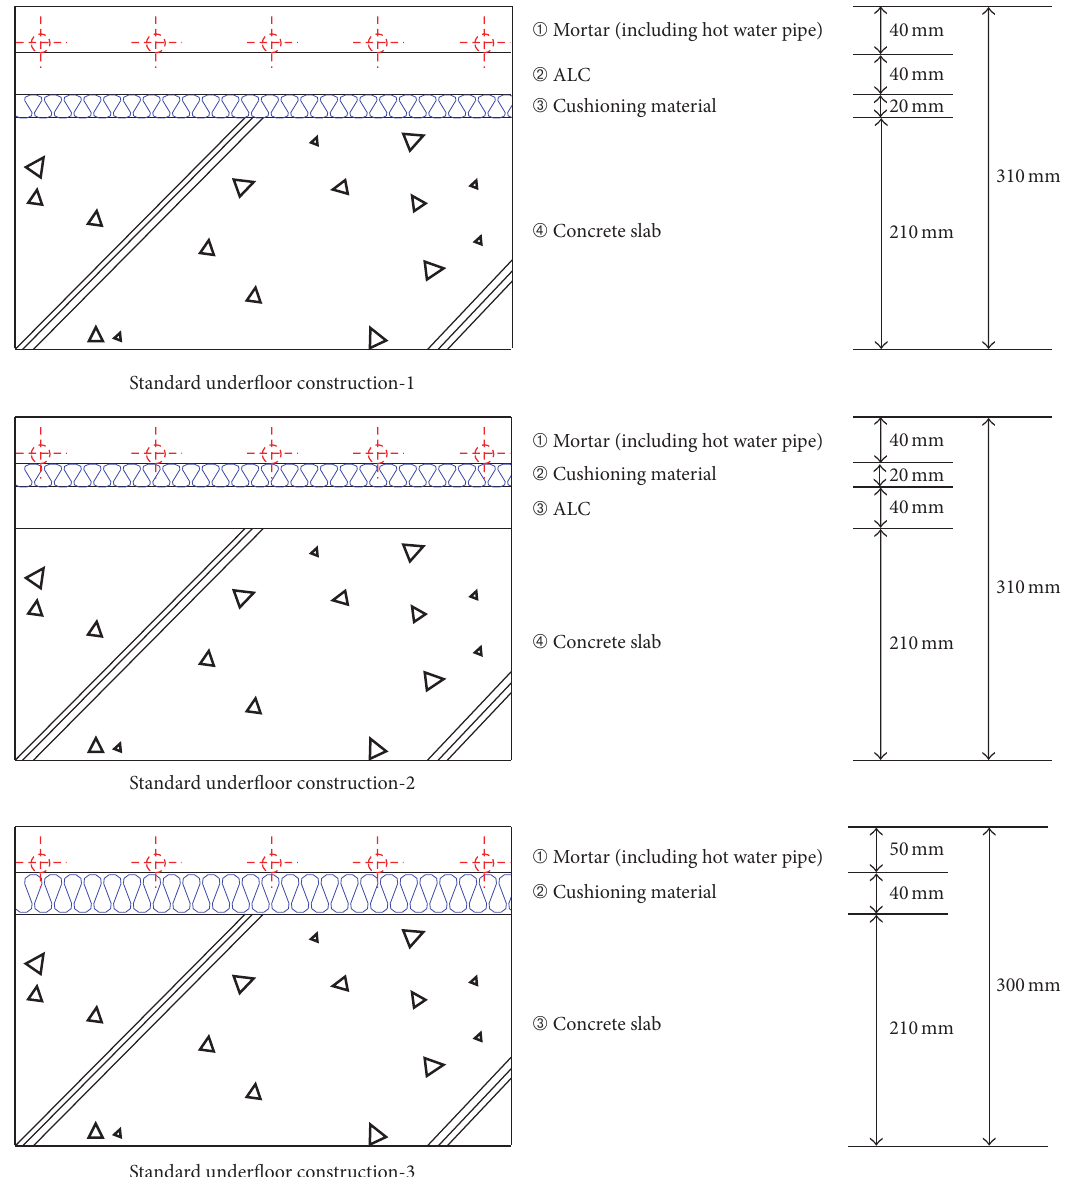
Figure 1: Standard underfloor structures proposed by